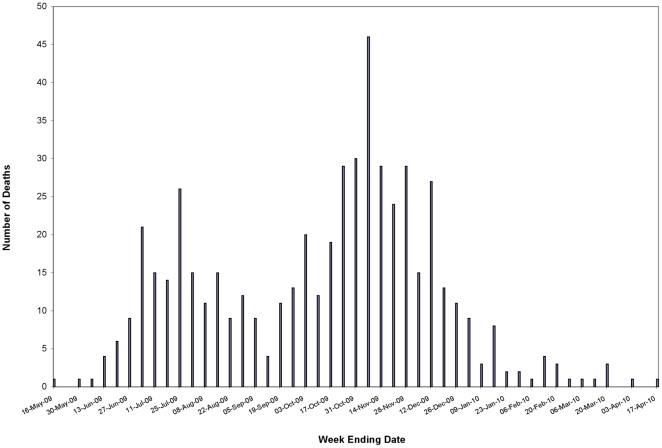
Fatal cases of 2009 pandemic (H1N1) influenza A in California by date of death.In California, mortality peaks due to 2009 pandemic (H1N1) influenza A coincided with two waves of 2009 H1N1 activity: April 3-October 3, 2009, and October 4, 2009-February 4, 2010. The influenza fatality rate remained highest for 50–59 year-olds during both time periods.